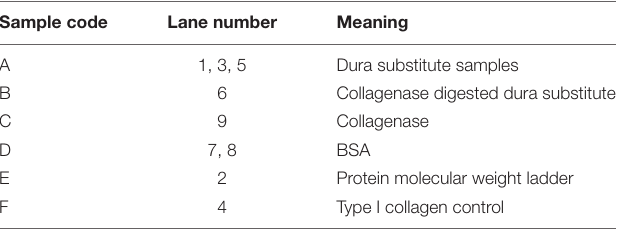
TABLE 1 | The meaning meanings of sample codes and lane